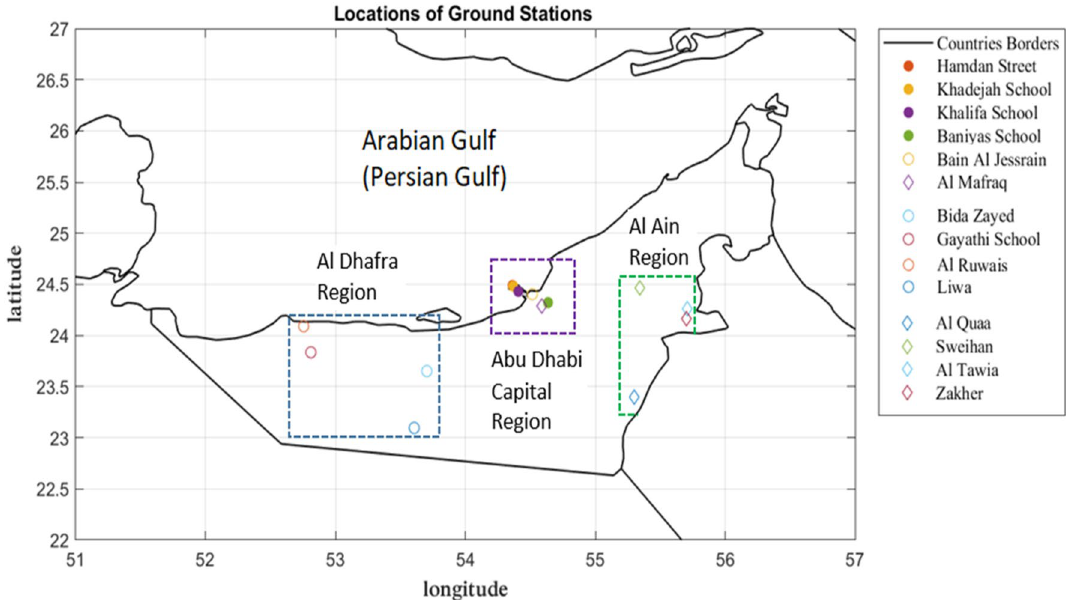
Figure 1. The locations of 14 ground stations on the map of the UAE (note: stations 1–3 are located relatively close to each other in Abu Dhabi City).